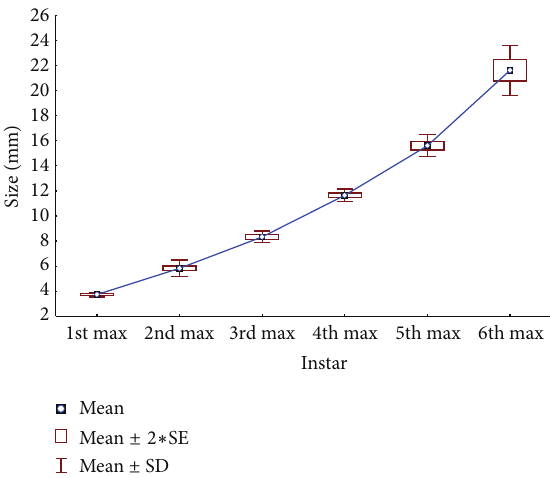
Figure 4: Growth curve of Cosmosoma auge larvae raised at Coj´ımar, Havana, under laboratory conditions (September-October 2011). In each stage lengths were taken in the premolt phase.